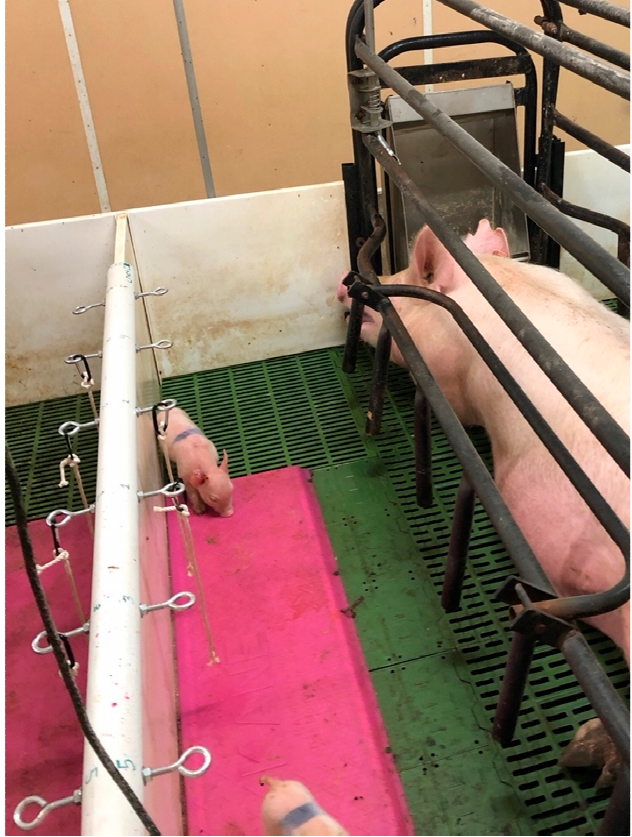
Figure 2. Photograph of the PVC (polyvinyl chloride) device used to hang enrichment ropes. The device, which measured 1.7 m in length, had a 2.7 cm cutout taken out of the bottom of the PVC. This cutout was placed over the top of the 2.5 cm thick plastic siding between two farrowing stalls. In this figure, the eyebolt locations visible (from bottom to top of the photo) are 5, 3, 1, 2, 4, 6. 2.3. Treatments